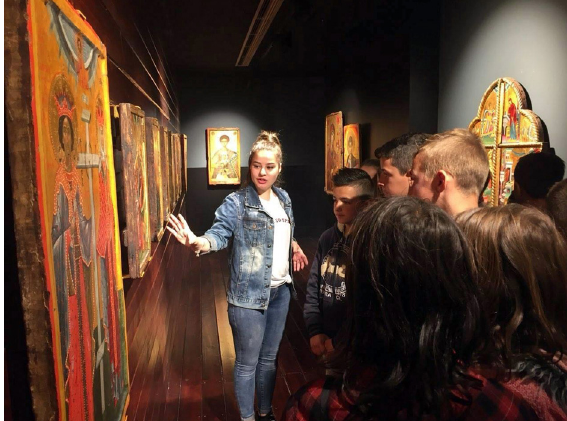
Fig. 5. A Geography student during voluntary practice in the